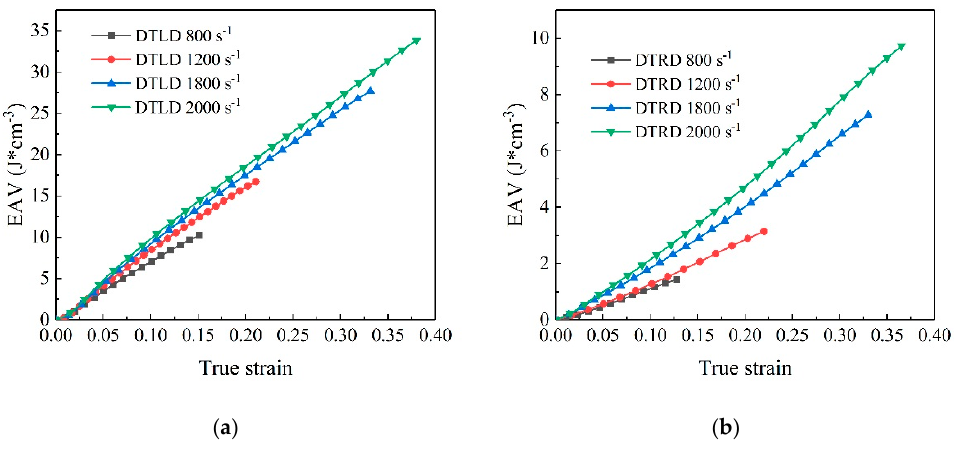
Figure 10. Absorbed energy per unit volume under different strain rates: ( a ) DTLD results and ( b ) DTRD results.